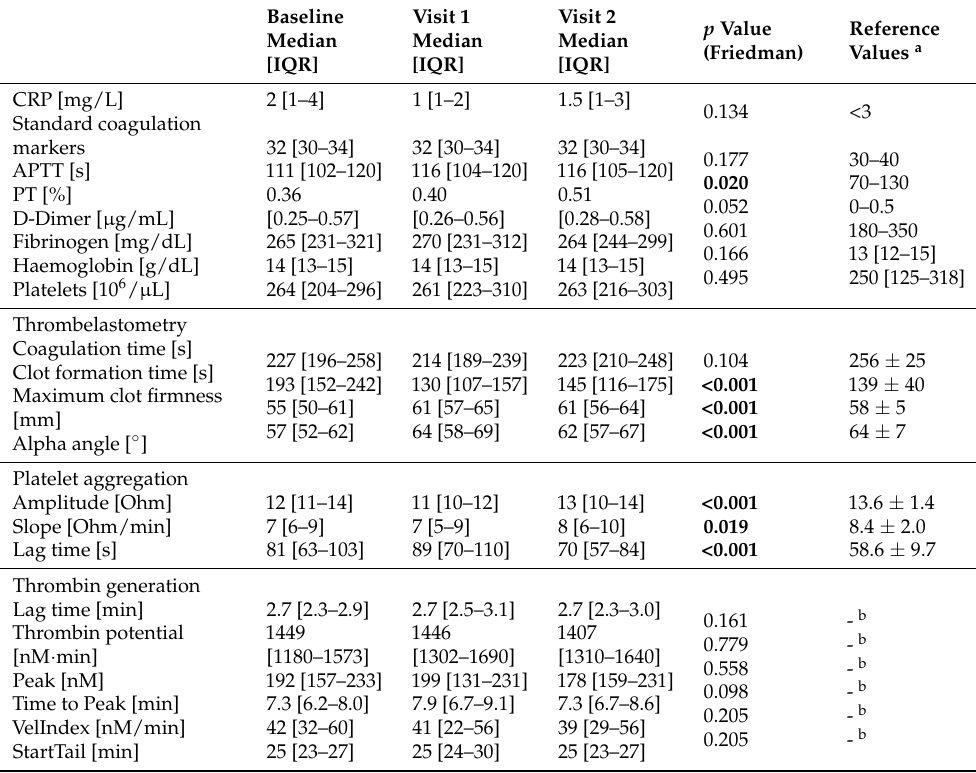
Table 2. Coagulation markers pre- and post-vaccination in T1DM patients. Data are expressed as median and IQR. p Values were calculated by means of the Friedman test ( n = 41). Abbreviations: APTT, activated partial thromboplastin time; PT, prothrombin time. a see references [11,14]; b reference values do not exist.